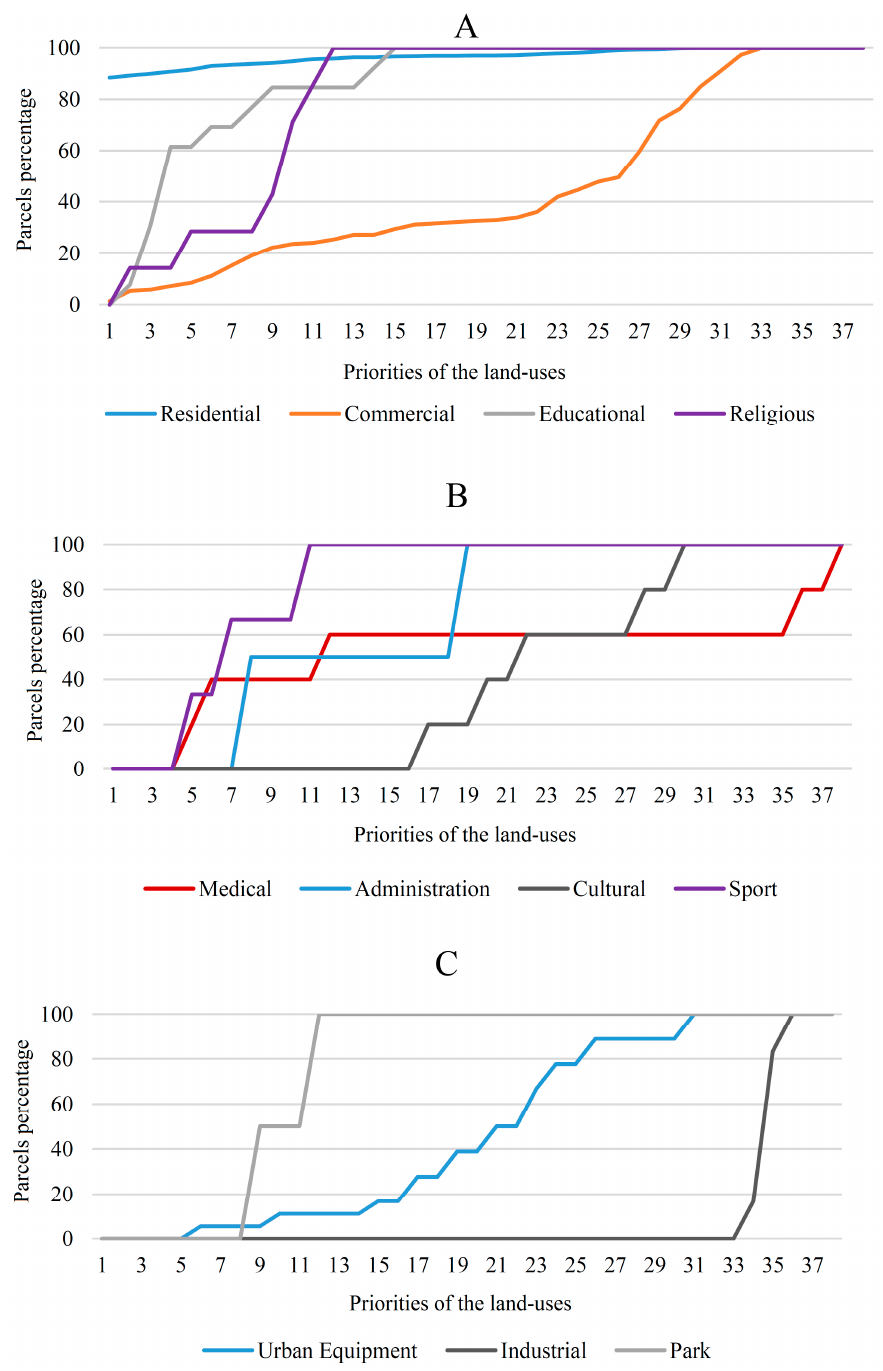
Figure 7. Diagram of the current land-uses percentage in different priorities (the vertical and horizontal axes show the percentages and the different priorities of the land-uses respectively).